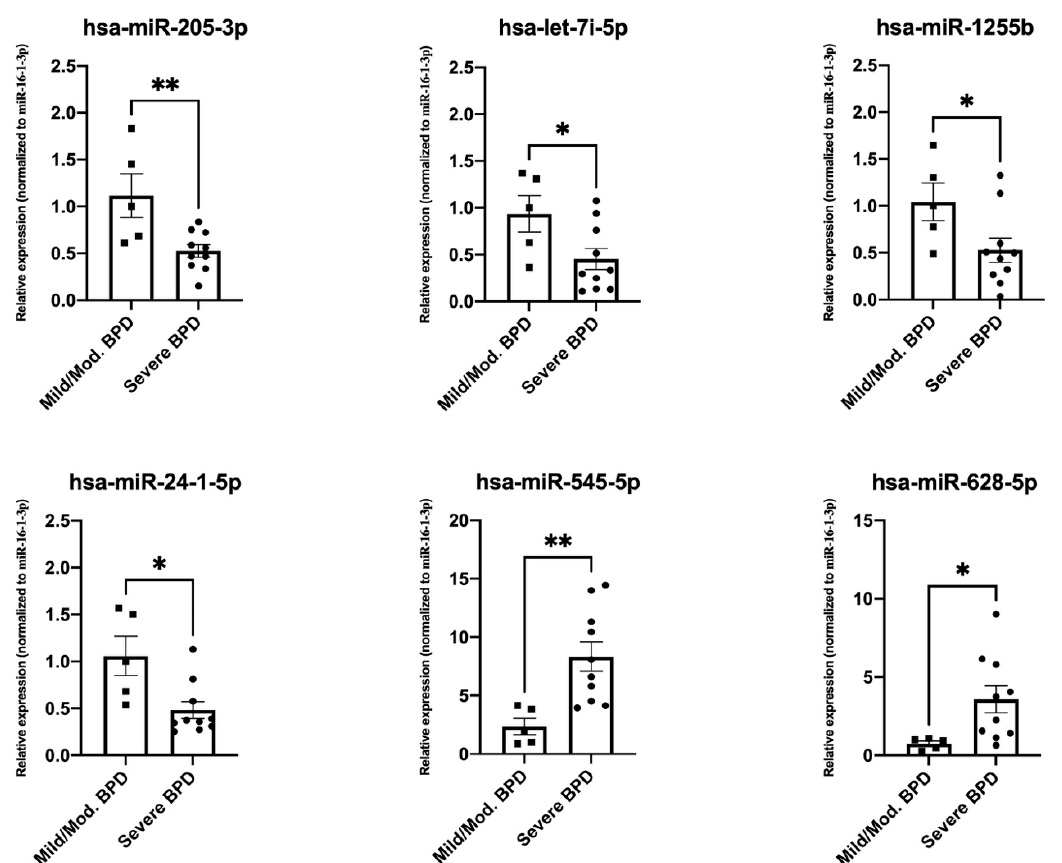
Figure 4. Validation experiments by real-time PCR and specific primers for hsa-miR-205-3p, hsa-let-7i-5p, hsa-miR-1255b, hsa-miR-24-1-5p, hsa-miR-545-5p, and hsa-miR-628-5p in a subset of mild/moderate (Mild/Mod.) BPD samples ( n = 5) and severe BPD samples ( n = 10). Y axes indicate relative expression values after normalization to hsa-miR-16-1-3p, and a mild/moderate calibration sample using the 2 − ∆∆ C T method [32,35]. Significant differences were determined by t-test using the GraphPad software (* p < 0.05, ** p < 0.01). Table 3. IPA pathways associated with differentially expressed